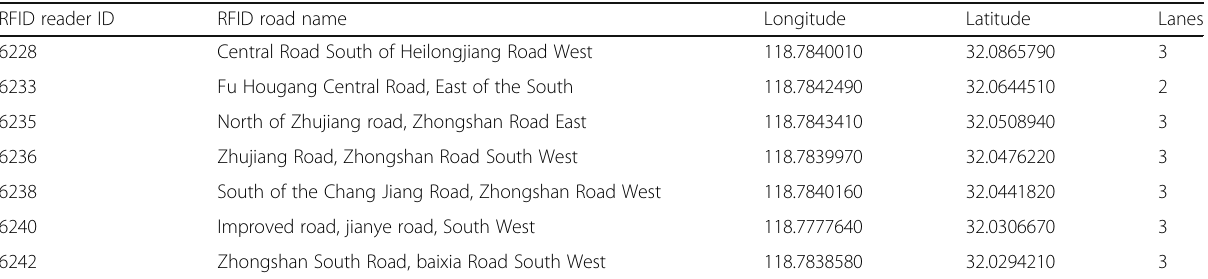
Table 3 RFID reader data RFID reader ID